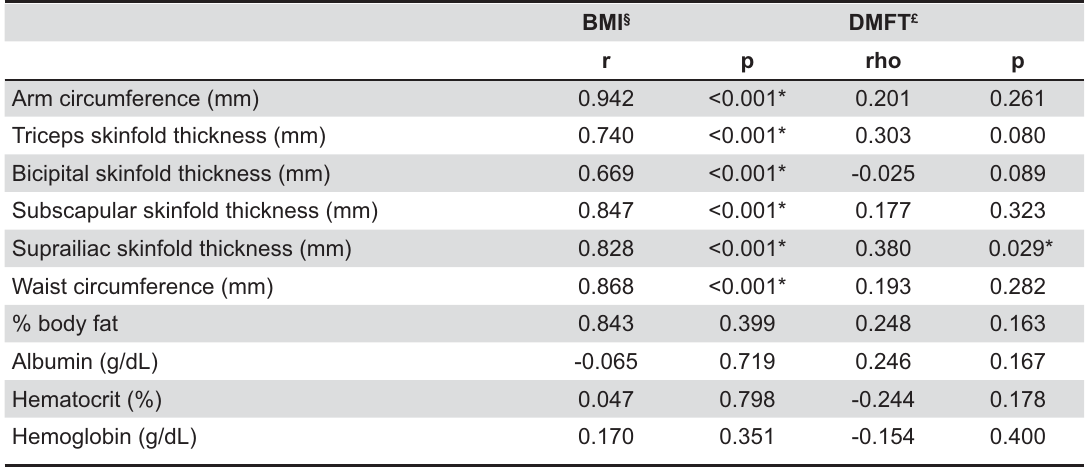
Table 5- (cid:14)(cid:127)]’’(cid:9)(cid:21)(cid:11)(cid:22)(cid:16)](cid:18)(cid:14)_(cid:9)(cid:22)?(cid:9)(cid:9)(cid:18)(cid:14)‘](cid:8)(cid:12)(cid:14)(cid:4)(cid:11)(cid:17)(cid:17)(cid:14)j(cid:18)(cid:8)(cid:9)+(cid:14)&‘(cid:4)j(cid:27)(cid:14)(cid:11)(cid:18)(cid:8)(cid:14)(cid:8)(cid:9)(cid:10)(cid:11)(cid:12)(cid:9)(cid:8)(cid:13)(cid:14)(cid:15)(cid:16)(cid:17)(cid:17)(cid:16)(cid:18)(cid:19)(cid:14)(cid:11)(cid:18)(cid:8)(cid:14)(cid:20)(cid:21)(cid:21)(cid:9)(cid:8)(cid:14)(cid:22)(cid:9)(cid:9)(cid:22)(cid:23)(cid:14)&(cid:3)(cid:4)(cid:5)(cid:6)(cid:27)(cid:14)?(cid:16)(cid:22)(cid:23)(cid:14)(cid:11)(cid:18)(cid:22)(cid:23)’]O](cid:15)(cid:9)(cid:22)’(cid:16)(cid:10)(cid:14) and clinical data. ( § Pearson and £